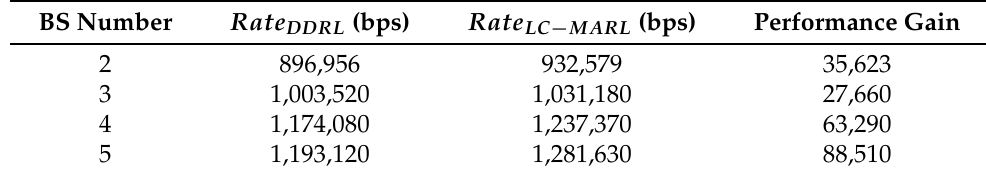
Table 6. Performance comparison in different BS numbers.